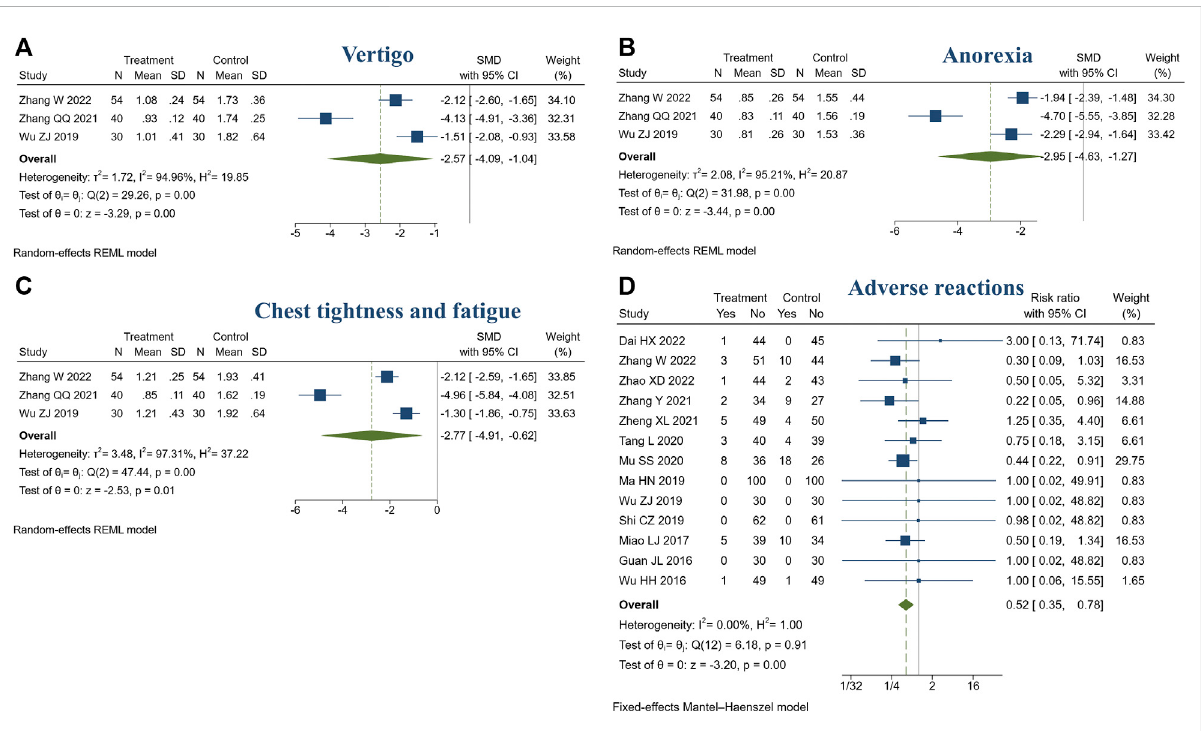
FIGURE 8 Forest plot of TCM symptom score and adverse reactions. (A) Vertigo; (B) Anorexia; (C) Chest tightness and fatigue; (D) Adverse